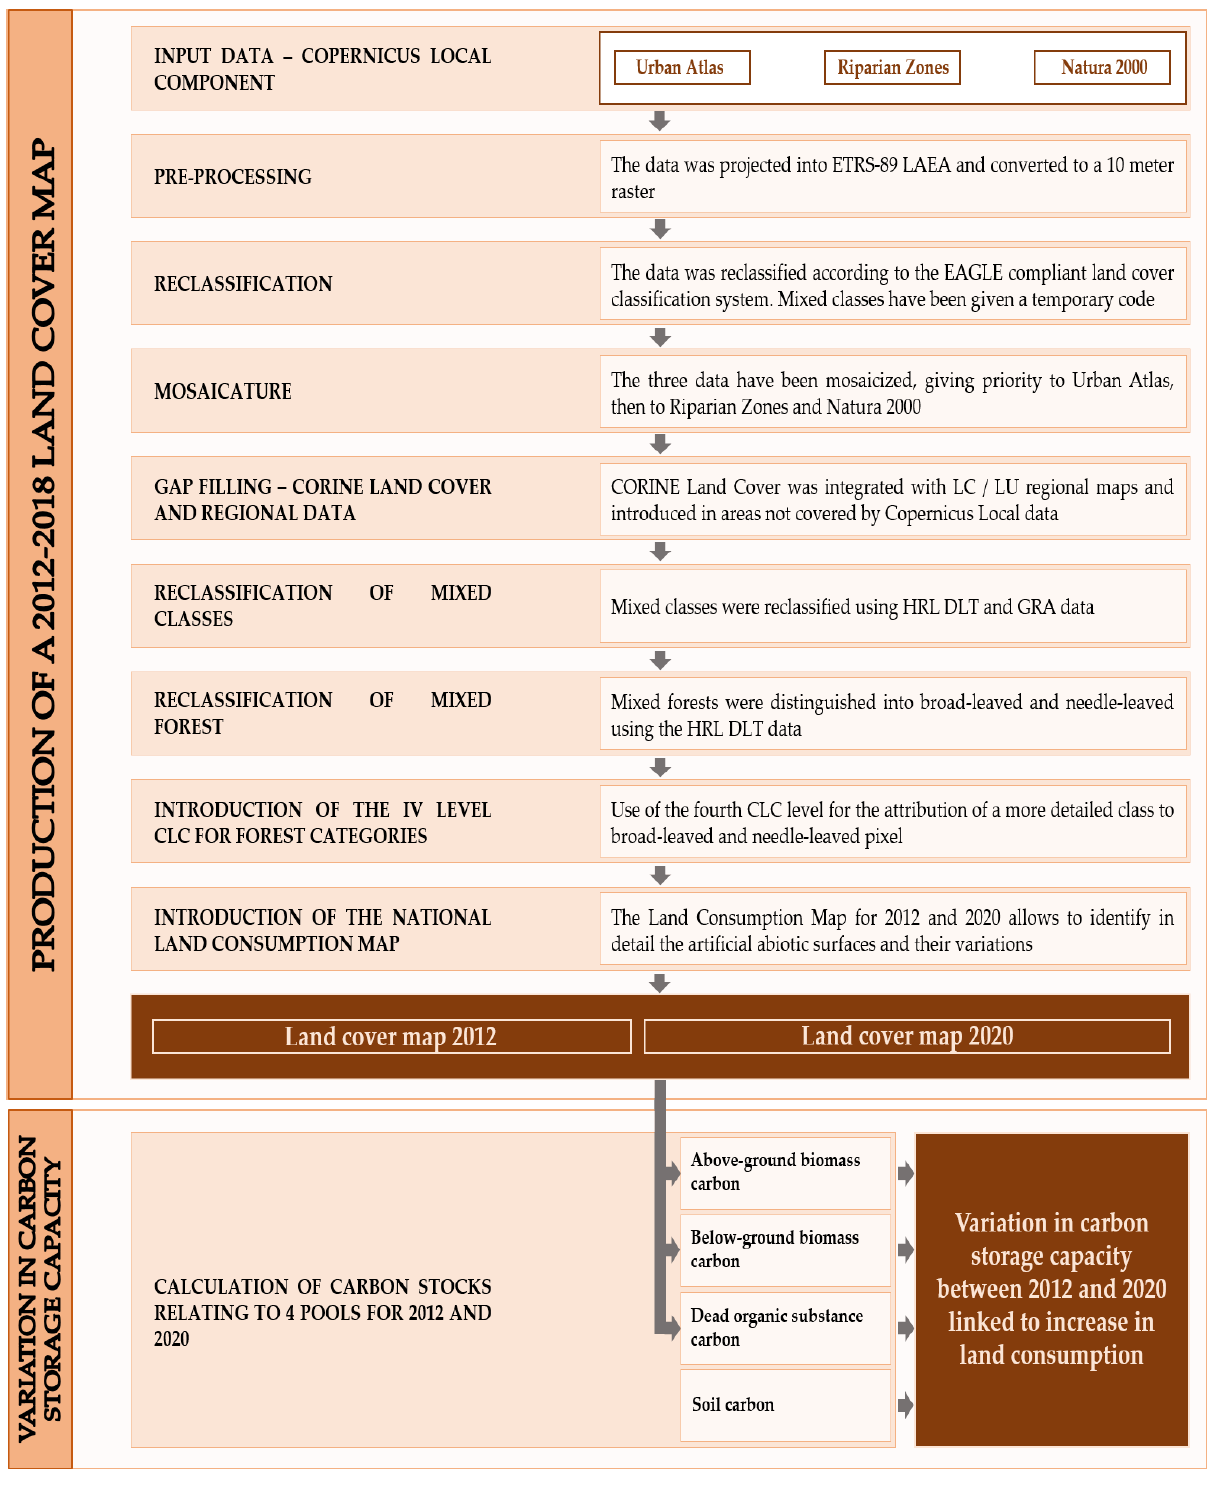
Figure 1. Workflow of the methodology for the production of the land cover map and evaluation of ecosystem services. The mosaic between Urban Atlas, Riparian Zones, and Natura 2000 was created (projected and rasterized at 10 m), then supplemented with the regional maps and CORINE Land Cover in the areas not covered by these three data. The distinction of forest categories and mixed classes was based on HRLs, while the National Land Consumption Map for 2012 and 2020 made it possible to identify artificial abiotic surfaces and their variation. The map allowed the calculation of three of the four pools considered for the estimation of the variation in carbon storage capacity.